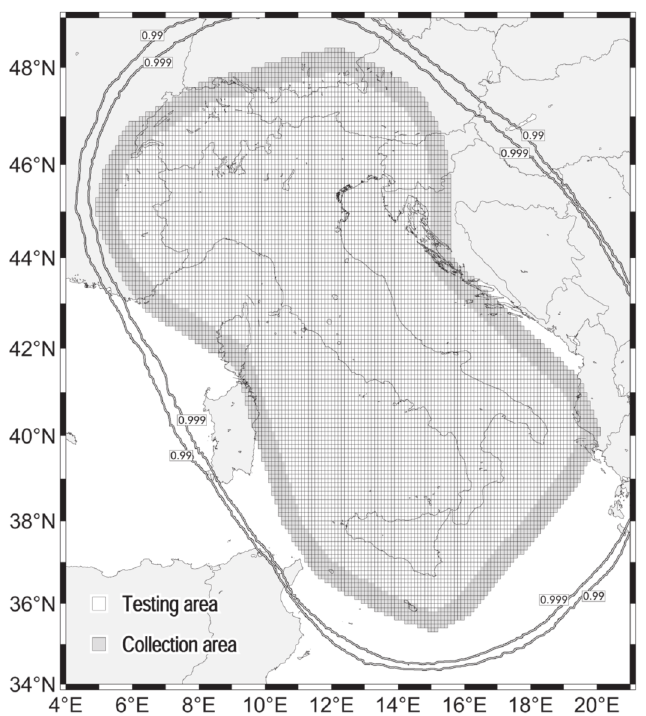
Figure 2. Definition of the collection area and testing area. Cells of testing area and collection area for the Italian testing region. The white boxes indicate cells of the testing area. The gray boxes indicate the cells of the collection area which includes the cells of the testing area as well. The white lines show contours of detection probabilities for events of magnitude M ≥ 3.7 at the P = 0.99 and P = 0.999 level on June 1, 2007. E E